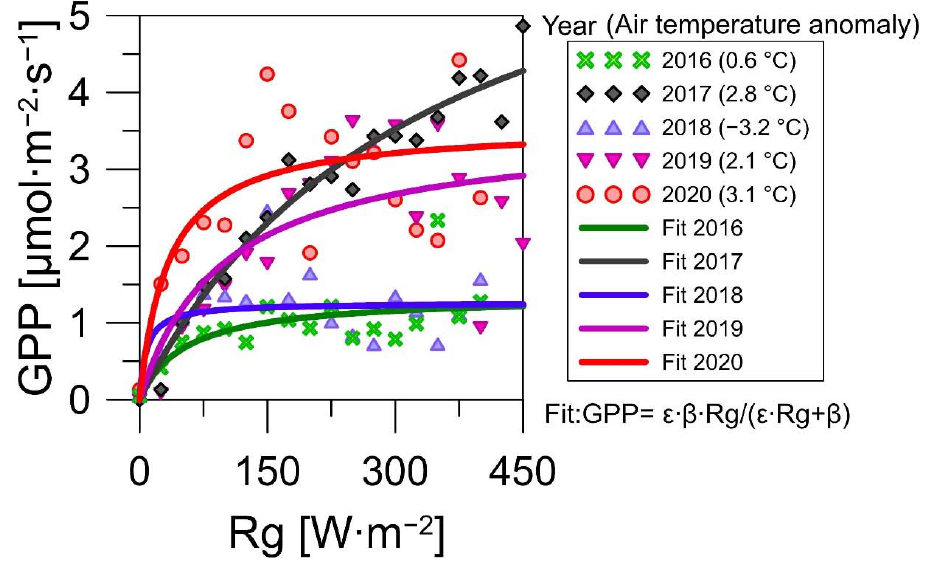
Figure 6. Light–response curves (Equation (3)) of the gross primary production (GPP) values calcu-